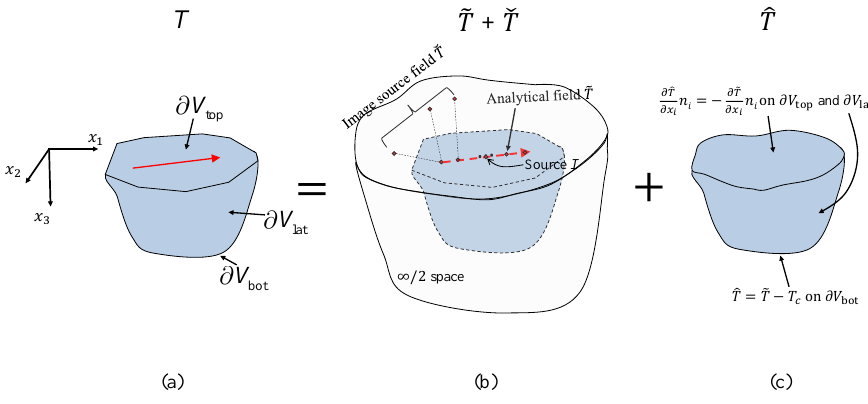
Figure 1. ( a ) A laser scanning is applied on the top surface of the body V . ( b ) The scanning line is discretized by a finite number of heat sources. Image sources by mirroring the original heat sources are added with respect to the boundaries. In a semi-infinite space, the temperature caused by the original discretized heat sources is ˜ T , and the temperature caused by the image sources is ˘ T . ( c ) Temperature filed ˆ T is employed to account for the boundary conditions (BCs). The total temperature T can be decomposed as the superposition of ˜ T , ˘ T , and ˆ T